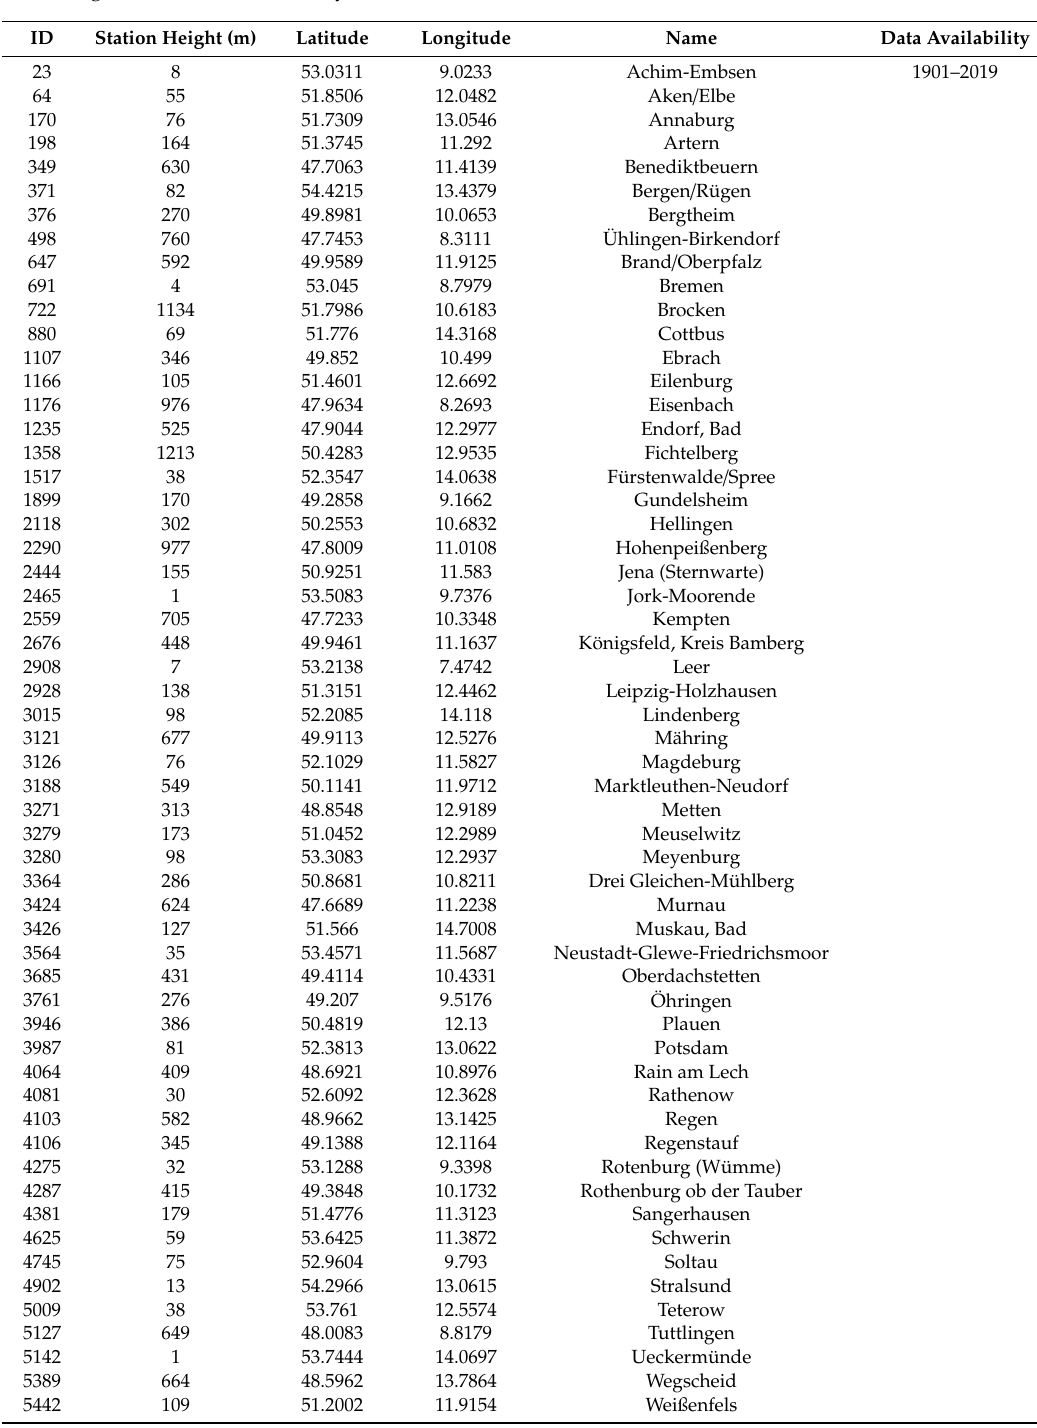
Table A1. Stations with less than two missing trend values for CLINO periods between 1901 and 2019 (cf. Figure 1, last access January